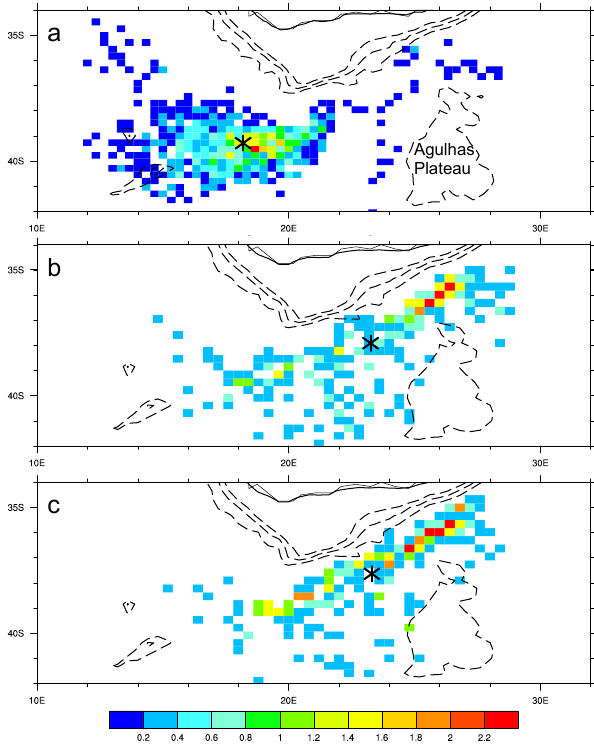
Fig. 4. Probability density of the retroflection position from (a) satellite altimetry, (b) POP CTRL and (c) POP NoITF simulation. The black crosses indicate the average retroflection position from the all time series. Bathymetric contours are at depth of 1000m, 2000m and